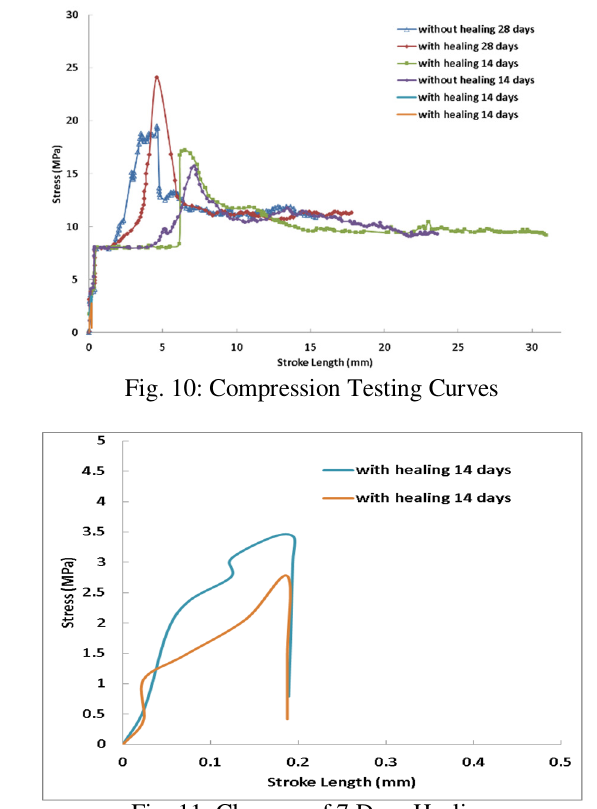
Fig. 11: Close up of 7 Days Healing Table 3: Comparison of